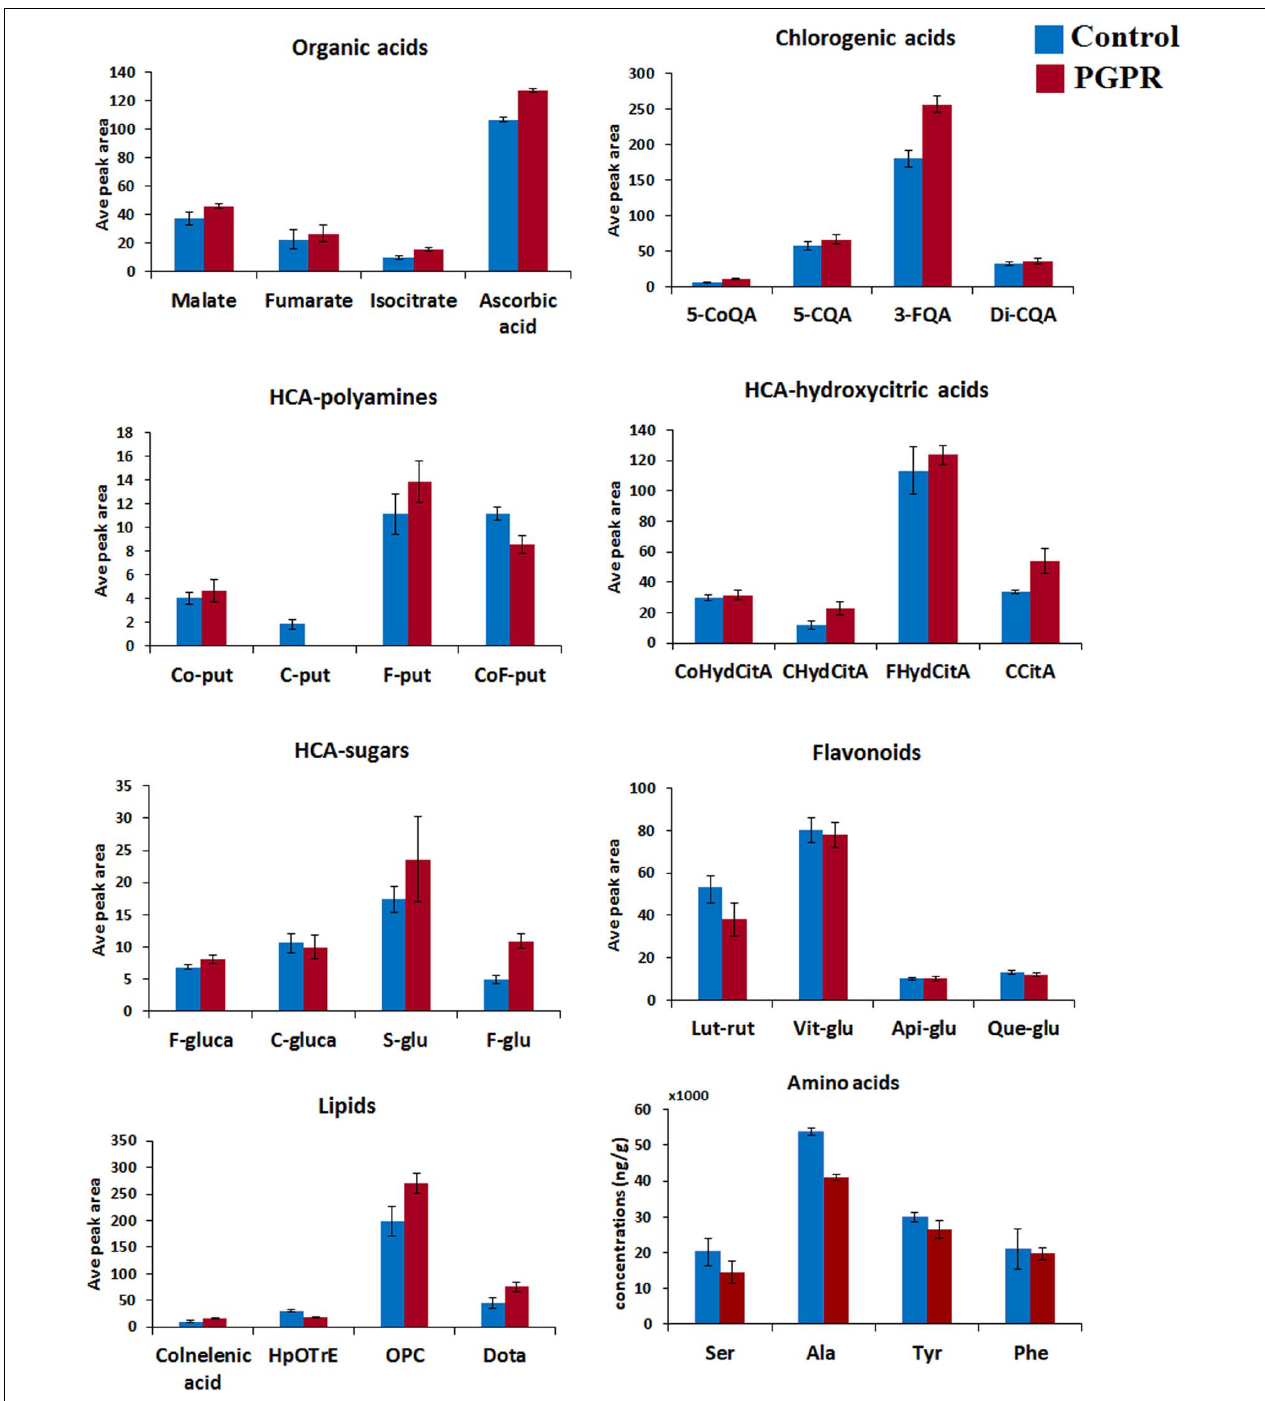
FIGURE 2 | Differential quantitative profiles of some of the representative metabolites within main classes (organic acids, chlorogenic acids, HCA-hydroxycitric acids, HCA-amides, flavonoids, amino acids and lipids) in maize leaves. The bar graphs were generated using the average integrated peak area ( n = 9) and the error bars represent the standard deviation. For statistical significance evaluation, the p -values are reported Supplementary Table 1 . CoQA, coumaroylquinic acid; CQA, caffeoylqunic acid; FQA, feruloylquinic acid; Co-put, coumaroyl putrescine; C-put, caffeoyl putrescine; F-put, feruloyl putrescine; CoF-put, coumaroyl feruloyl putrescine; CoHydCitA, coumaroyl hydroxycitric acid; CHydCitA, caffeoyl hydroxycitric acid; FHydCitA, feruloyl hydroxycitric acid; CCitA, caffeoylisocitric acid; F-gluca, feruloyl glucarate; C-gluca, caffeoyl glucarate; S-glu, sinapoyl glucose; F-glu, feruloyl glucose; Lut-rut, luteolin rutinoside; Vit-glu, vitexin; Api-glu, apigenin glucose; Que-glu, quercetin glucose; Dota, dihydroxy-octadecatrienoic acid; OPC, oxo-(pentenyl)cyclopentane-octanoic acid; HpOTrE, hydroperoxy-octadecatrienoic acid; Ser, serine; Ala, alanine; Tyr, tyrosinel; Phe, phenylalanine.